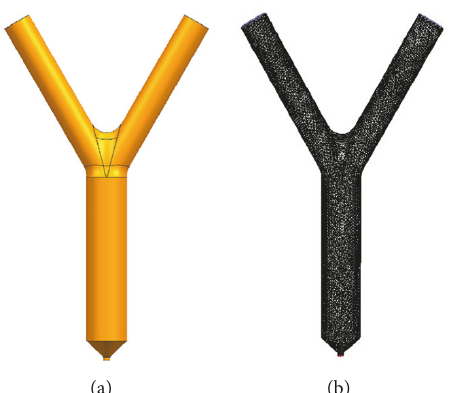
Figure 4: (a) 3D model and (b) finite element model of the flow channel.